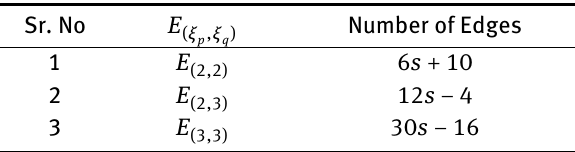
Table 1: The distribution of edges w.r.t. degree of end vertices of every edge.